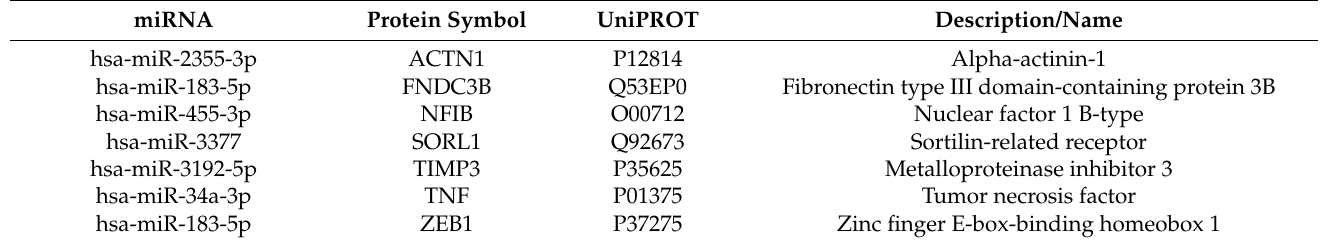
Table 2. Genes previously related to KC that are potentially regulated by miRNAs whose levels appear altered in KC stromal cell exosomes.